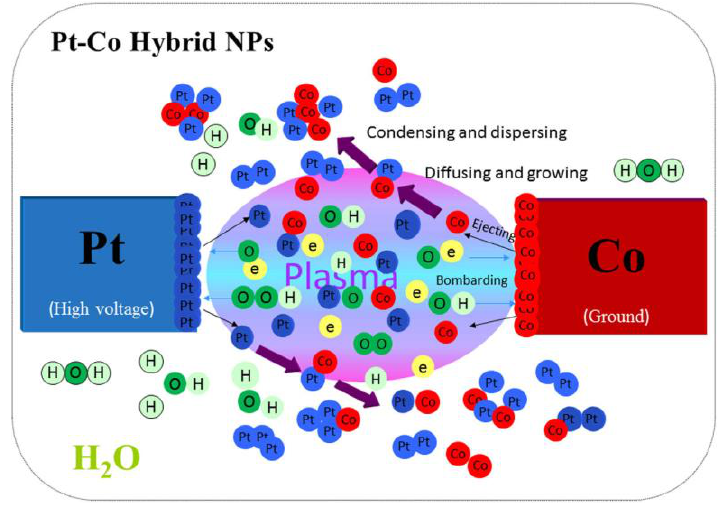
Figure 6. Schematic diagram for the synthesis of Pt/CoPt-1 composite NPs by solution plasma sputtering. Reproduced from [61] with permission from Nature, 2017.